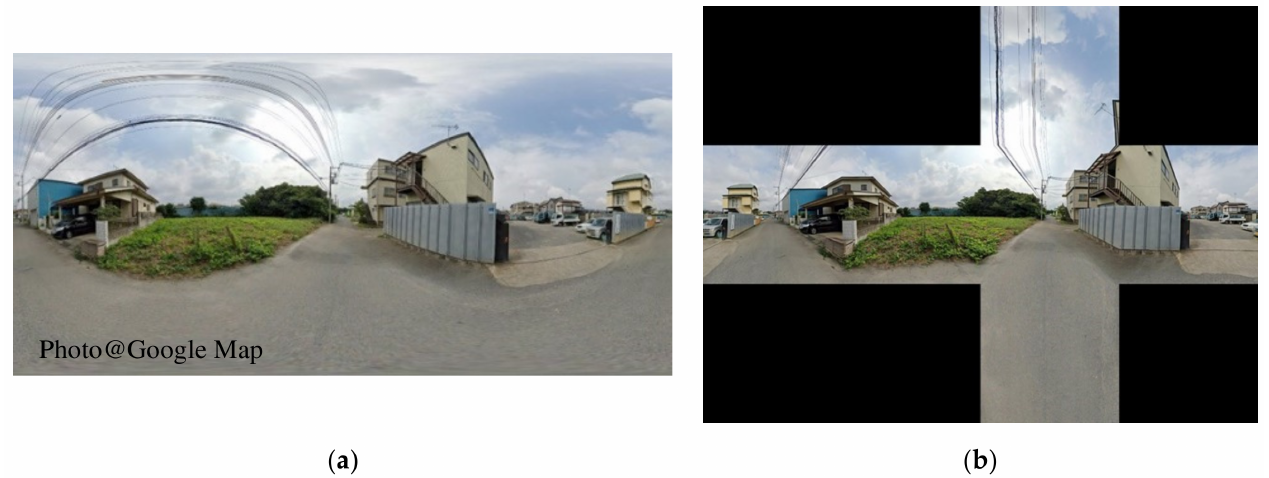
Figure 3. Conversion process showing the ( a ) the equirectangular image ( b ) created by a flattened sphere photo recorded by a 360 ◦ camera with the object bent to the cube-map